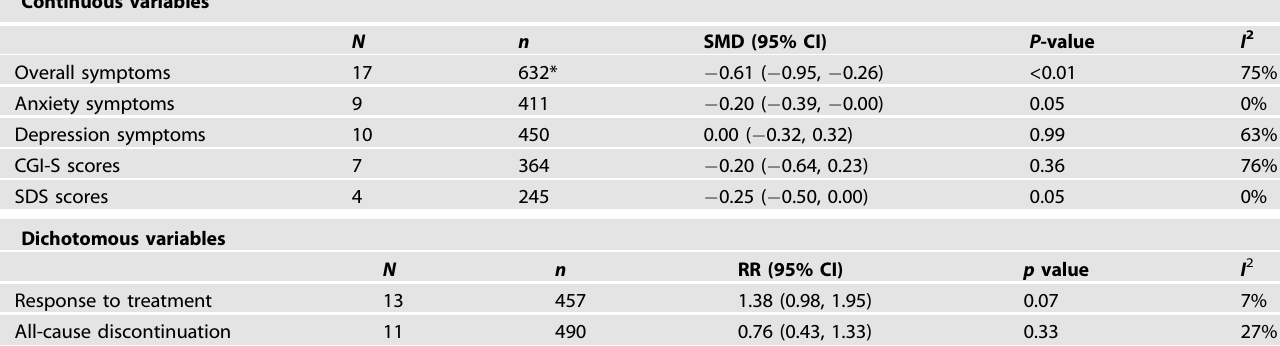
Table 2. Ef fi cacy, acceptability, and tolerability outcomes: pooled mitochondrial modulators versus placebo. Continuous variables